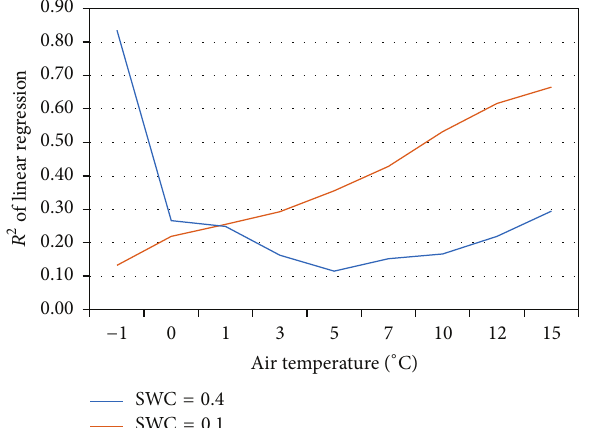
Figure 6: 𝑅 2 of linear regression for ET and LST with nine scenarios of air temperature and two scenarios of soil water